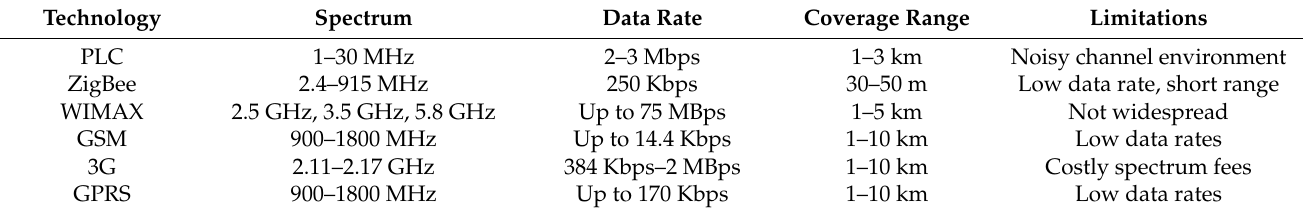
Table 1. Comparison of different communication